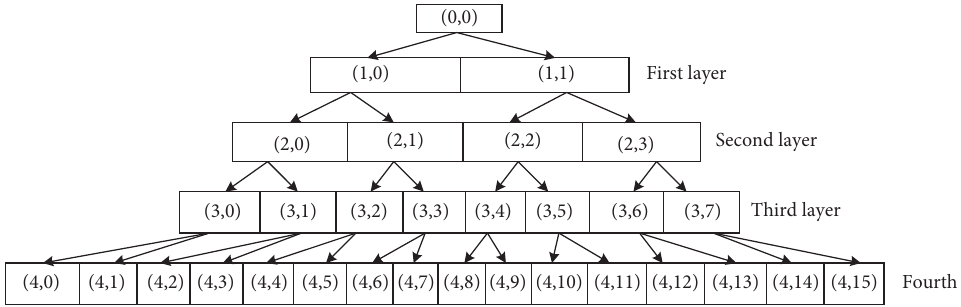
Figure 11: The decomposing tree of four-layer wavelet packet.